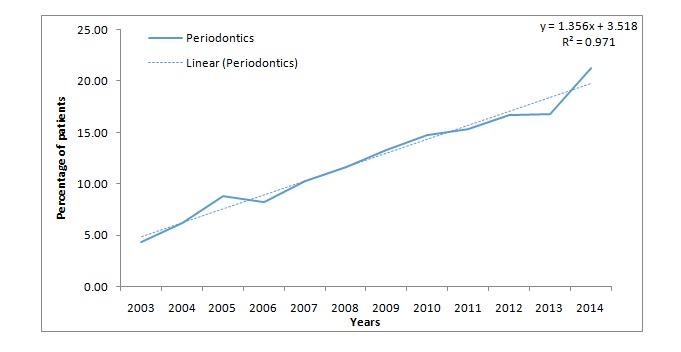
Graph 4: Trend line showing variation of referrals to periodontics department.